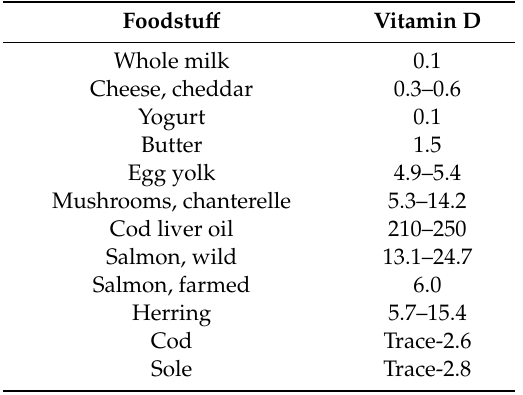
Table 4. Natural vitamin D content ( µ g / 100 g) in